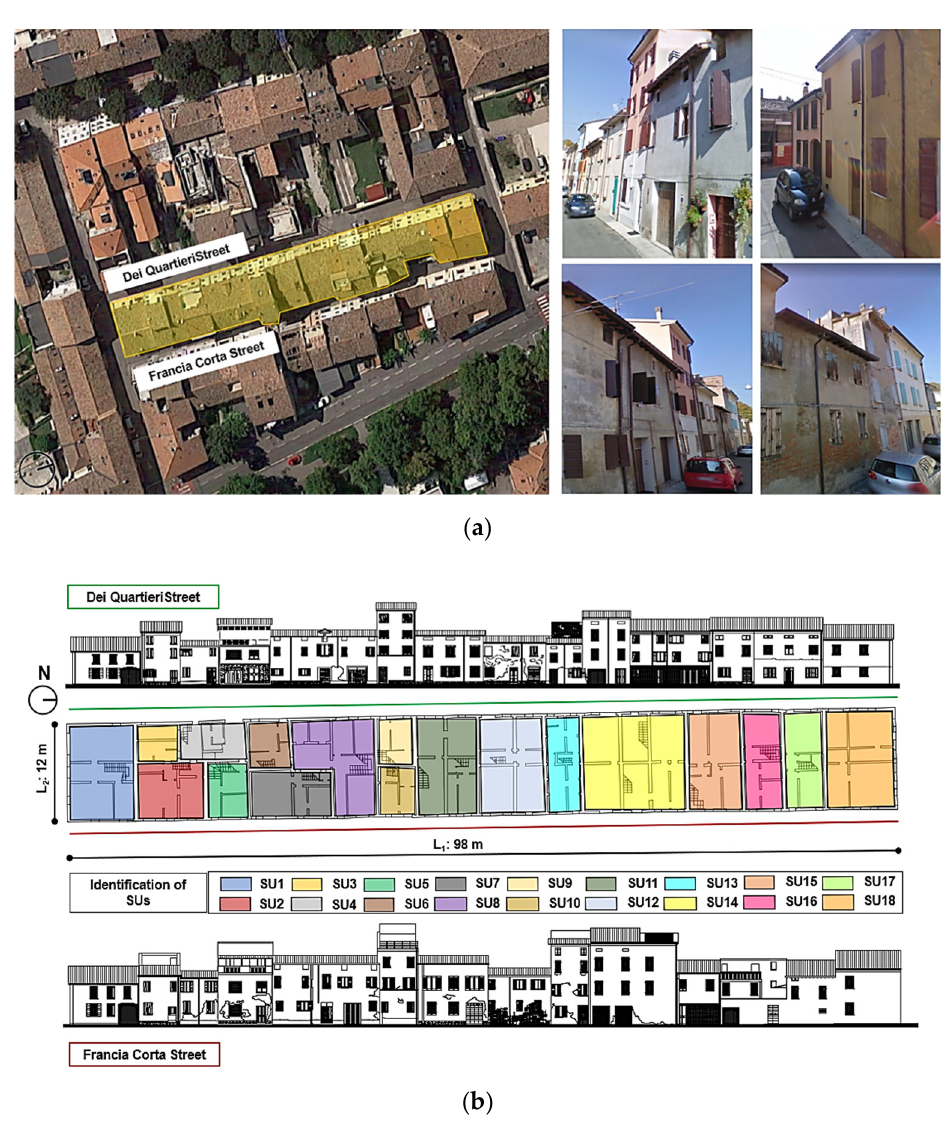
Figure 3. Identification of the case study aggregate ( a ) and view along the main street ( b ).